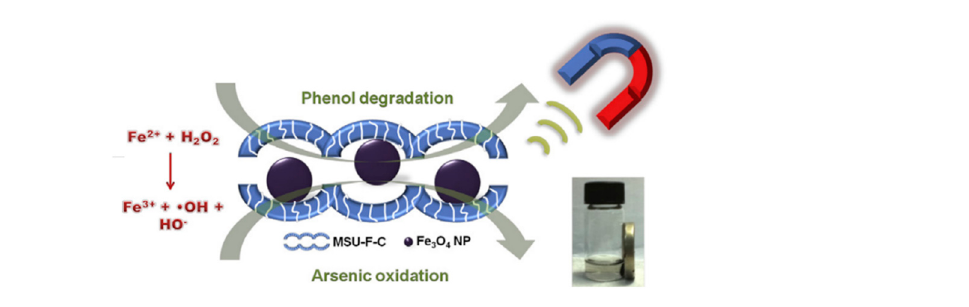
Figure 23. Removal of arsenic and phenol using Fe 3 O 4 /MSU-F-C as a catalytic adsorbent. (Reprinted with permission from [188]. Copyright © 2012 Elsevier Ltd. All rights reserved).